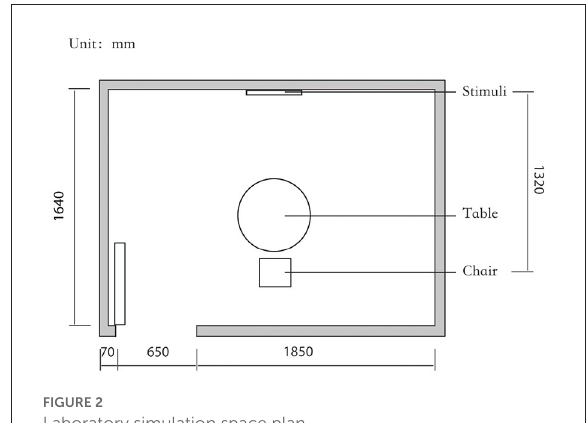
under different lighting conditions. To determine consistent